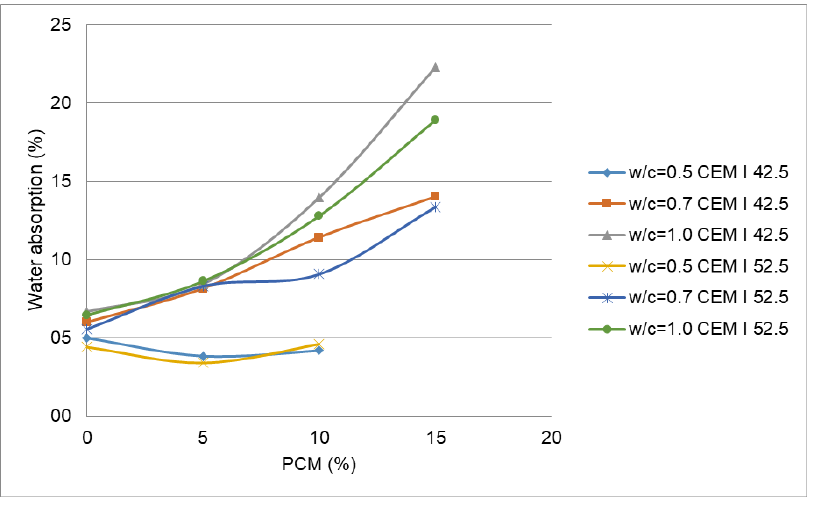
Figure 12. Water absorption in PX 27 mortar